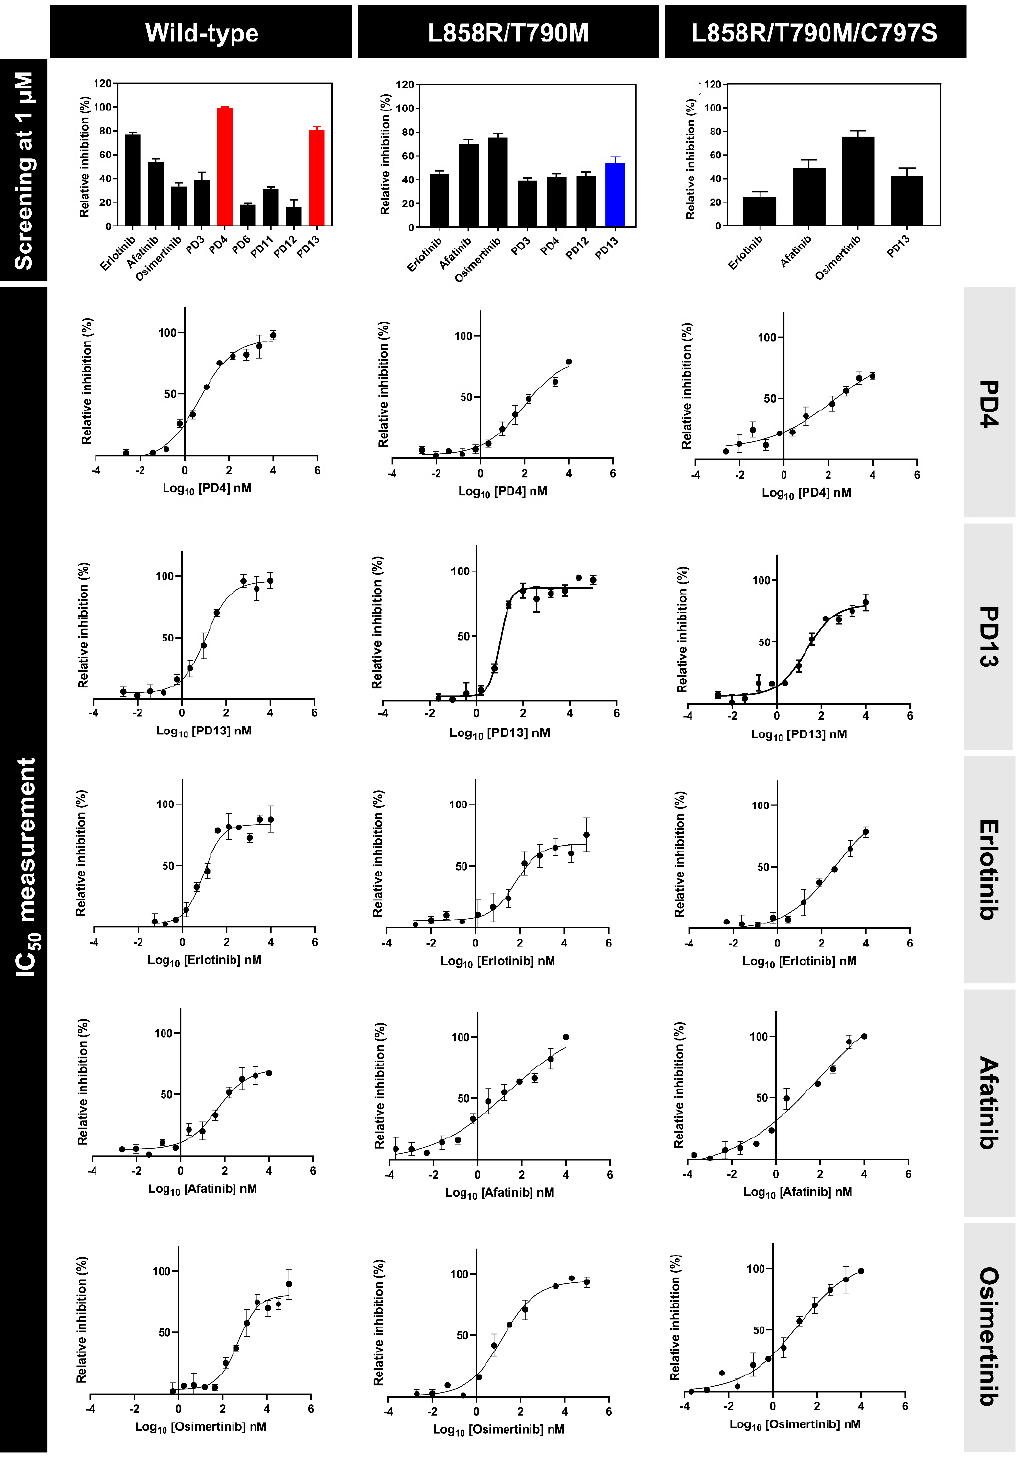
Figure 3. Three forms of EGFR (wild-type, L858R/T790M, and L858R/T790M/C797S) inhibitory screening of PD derivatives at 1 µM concentration ( top ) and IC 50 curves of compounds that present more than 50% PD4 and PD13 in comparison with reference drugs ( bottom ). Table 2. EGFR inhibitory activities of focused PD and drugs in different forms of EGFR.